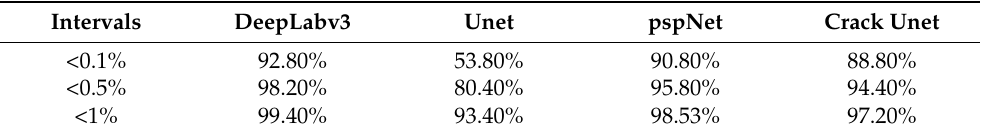
Figure 15. Segmentation results from non-crack data set.